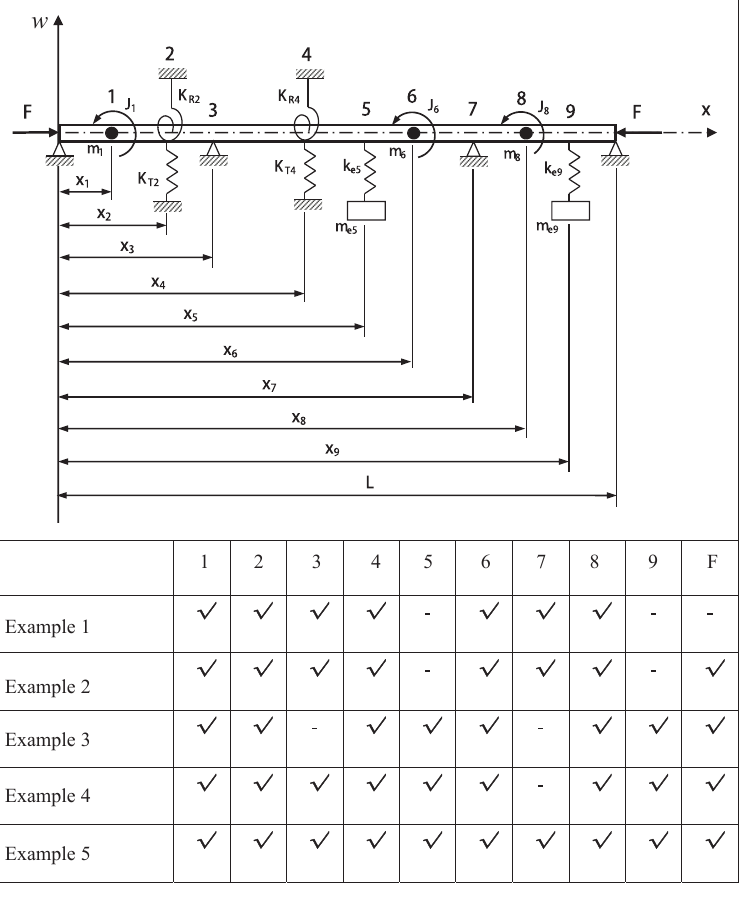
Fig. 3. A uniform pinned-pinned beam carrying three point masses, three rotary inertias, two linear springs, two rotational springs, two interme- diate pinned supports and two mass spring sytems and subjected to axial load. values obtained for the first five modes are presented and compared with the frequency values obtained for F r = 0 , 0 . 25 , 0 . 5 , 0 . 75 for compressive and tensile axial loads in Table 3. It can be seen from Table 3 that when the number of spring-mass system increases the natural frequencies decrease for both load conditions. While the compressive axial force decreases the natural frequencies, the tensile force increases them. It can also be seen from Table 3 that for two spring-mass systems the percentage change in frequency values with the increasing F r is in the 6–17% range while it is approximately 2% for the first mode. Therefore, it is more significant after the first mode. However, this significant percentage change in behaviour can be observed for all modes with no spring-mass and one spring-mass system. Also from the same table it is clear that; the third, fourth and fifth mode frequency values of one spring-mass system are almost the same as the second, third and fourth mode frequency values of no spring-mass system for all F r values. Besides, the fourth and fifth mode frequencies of two spring-mass systems are almost same as the third and fourth mode values of no spring-mass systems for all F r values. These similarities can be formulated as ω p + i = ω bi ( i = 2 , 3 , . . . ) , where p denotes the total number of spring-mass systems attached and ω bi denotes the i ’th natural frequency of the beam carrying concentrated elements for no spring-mass systems, for the Bernoulli-Euler beam carrying concentrated elements such as point masses, rotary inertias, linear springs and rotational springs, subjected to compressive or tensile axial loads. Furthermore, the first ( p + i ) mode shapes of the beam carrying concentrated elements and p spring-mass attach- ments have similar forms since the ( p + i ) ’th mode frequency value of the beam with attachments is very close to the second mode frequency value of beam carrying only concentrated elements without any spring-mass